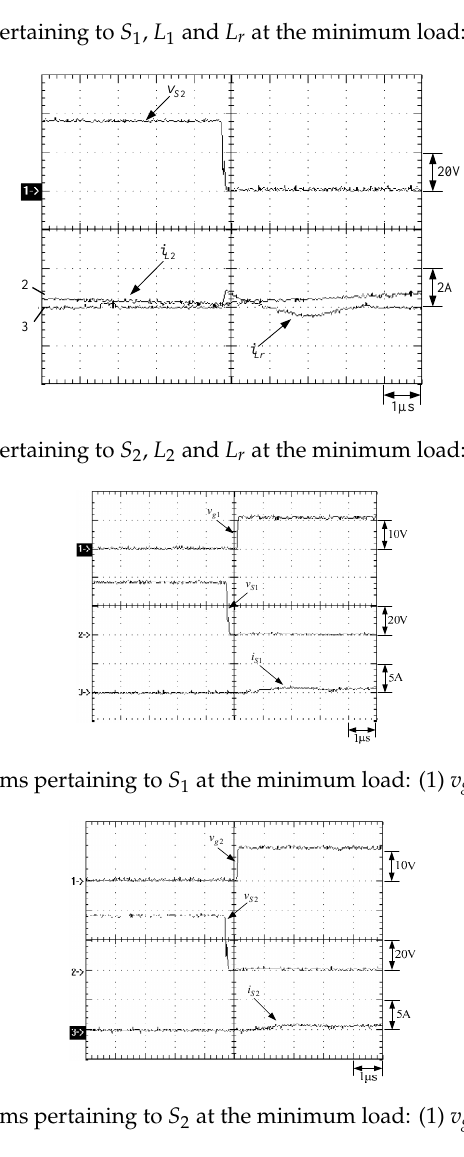
Figure 21. Waveforms pertaining to S a at the minimum load: (1) v ga ; (2) v Sa ; and (3) i Sa . Figure 22. Waveforms pertaining to S b at the minimum load: (1) v gb ; (2) v Sb ; and (3) i Sb .